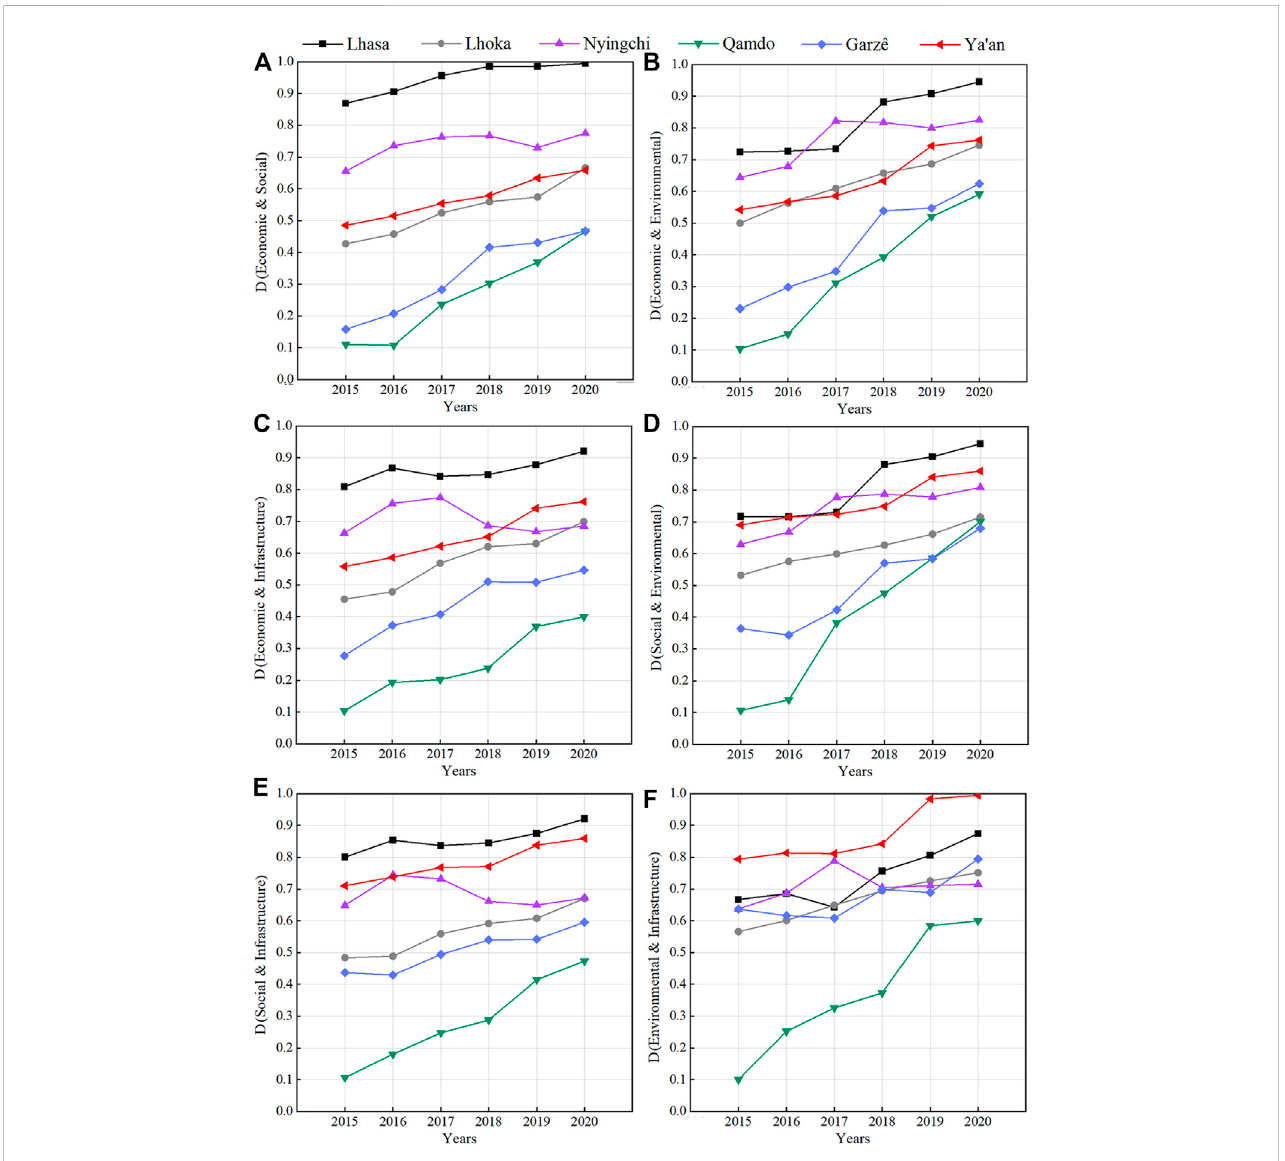
FIGURE 6 Trends in the evolution of aspects of resilience coupling coordination. (A) Economic & social. (B) Economic & environmental. (C) Economic & infrastructure. (D) Social & environmental. (E) Social & infrastructure. (F) Environmental &